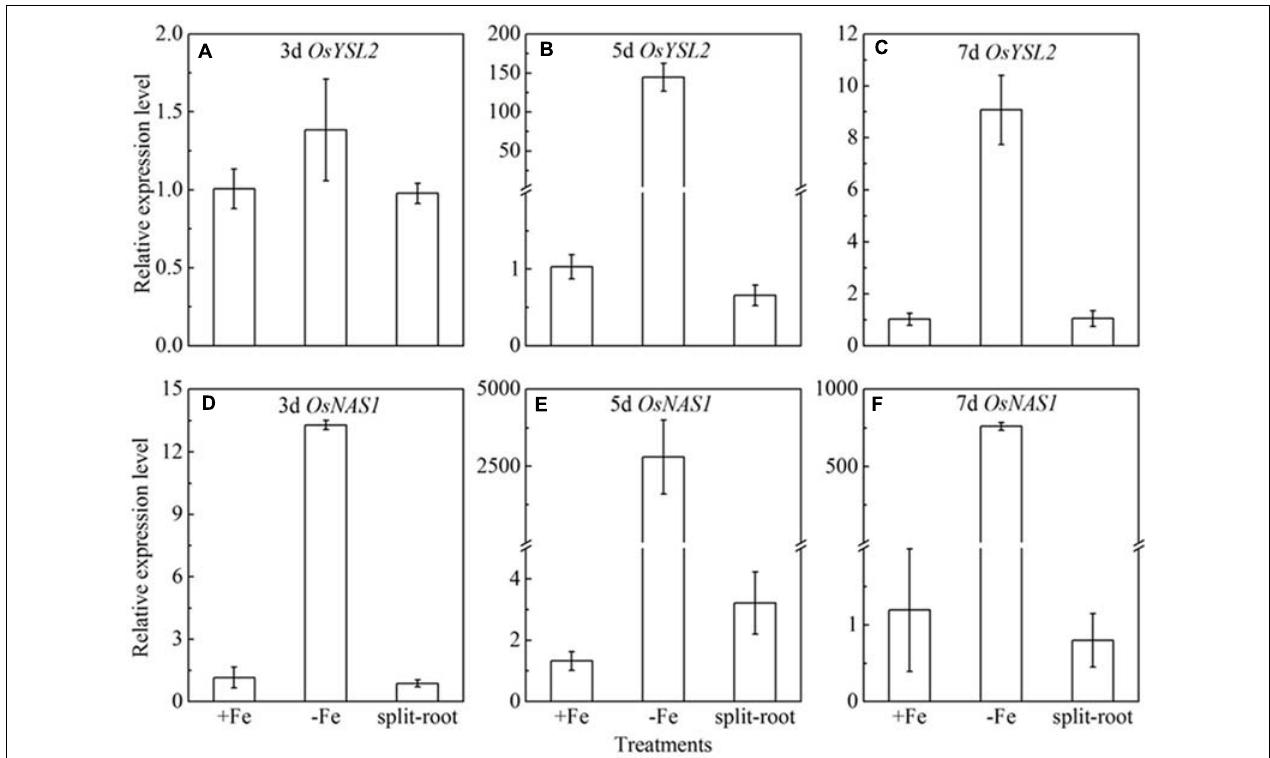
FIGURE 9 | Expression levels of OsYSL2 and OsNAS1 in rice shoot of the split root experiment. The part labels in figures indicate the expression levels of different genes after different days (3, 5, and 7 days) of iron deficiency treatment. (A–C) Expression levels of OsYSL2 at 3, 5, and 7 days; (D–F) Expression levels of OsNAS1 at 3, 5, and 7 days. Data are presented as means ± SE of three biological